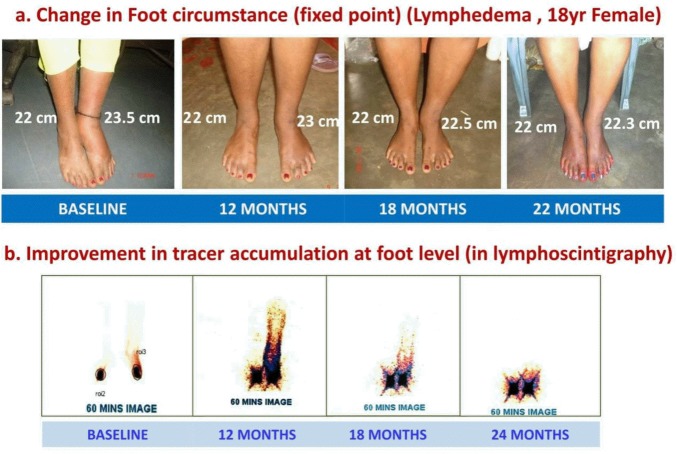
a & b: Post treatment reversibility of lymphedema of left leg in a symptomatic 18 year old female. (a) Change in foot circumference (fixed point over lateral maleolus). (b) Improvement in tracer accumulation at foot level (in lymphoscintigraphy).